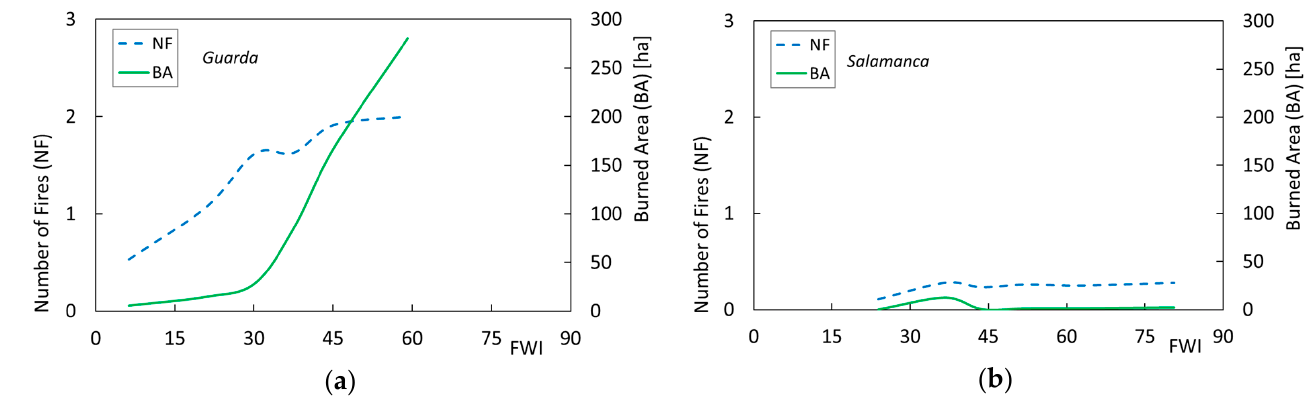
Figure 5 . Average number of daily fires (NF) and burned area (BA) as a function of FWI for: ( a ) Portuguese district of Guarda; and ( b ) Spanish province of Salamanca .